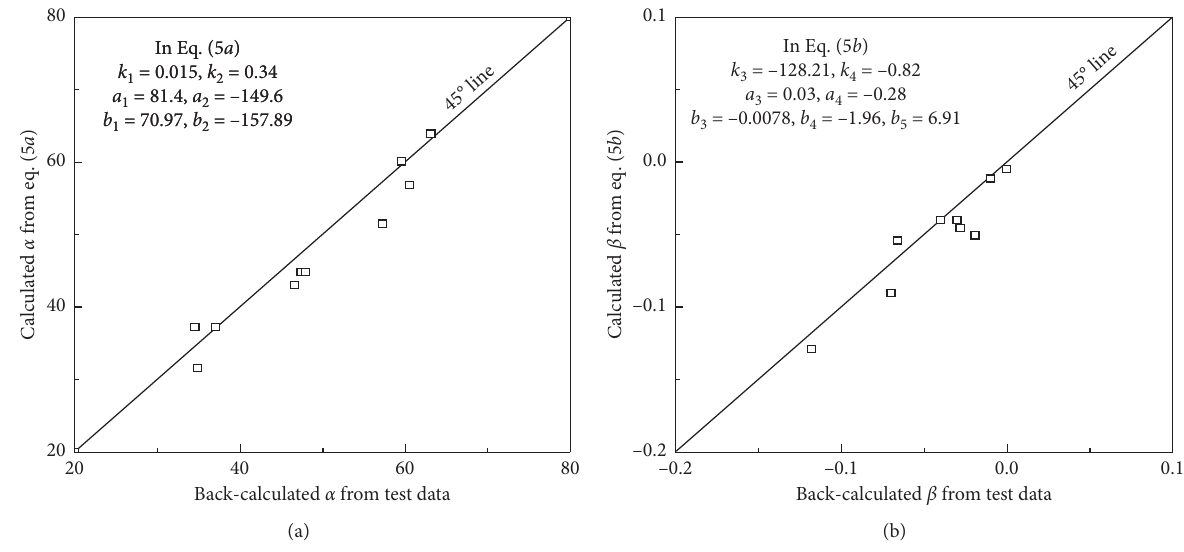
Figure 13: Comparison between predicted parameters α and β and back-calculated results from test data.